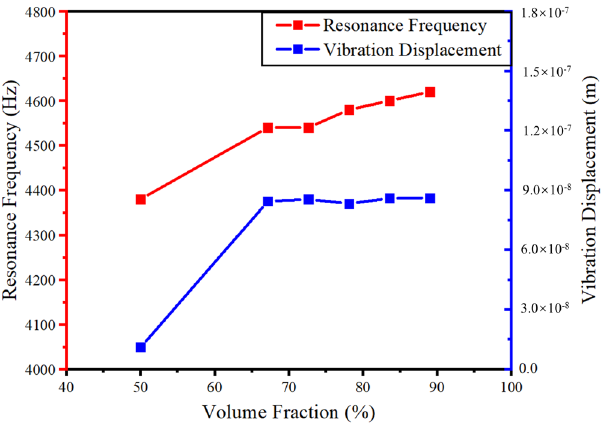
Figure 5. The curve of the resonance frequency and maximum vibration displacement with volume fraction of piezoelectric phase.